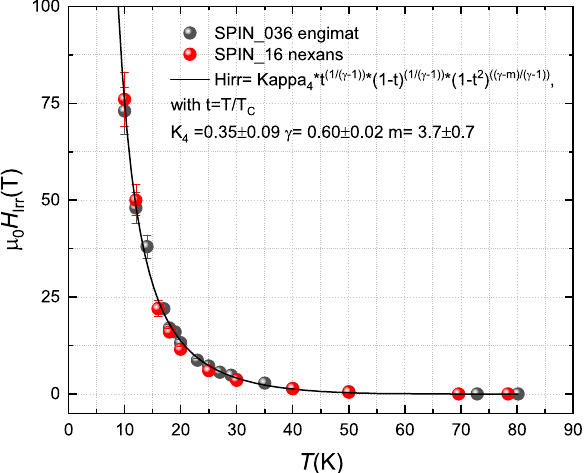
Figure 5. Irreversibility field as a function of temperature of both SPIN_036engimat (black circles) and SPIN_016nexans (red cycles). The expression used for calculation is in agreement with the reference reported. The black line represents the fit of SPIN_036engimat H irr ( T ) with the equation in 16 . The values of fitting parameters are also shown from which a good matching with H irr ( T ) curves obtained in 16 can be inferred.